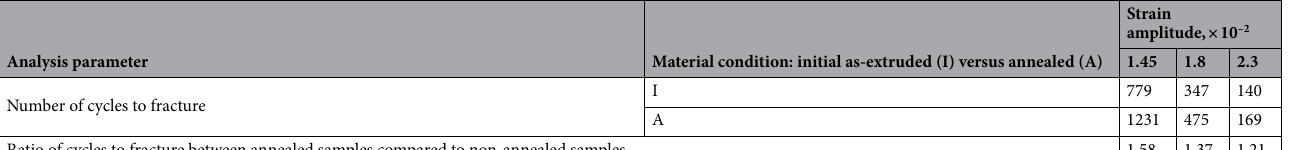
Ratio of cycles to fracture between annealed samples compared to non-annealed Table 2. LCF life for as-extruded and annealed specimens of Mg–1.5Nd alloy.